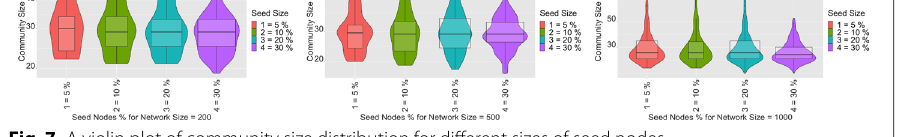
Fig. 7 A violin plot of community size distribution for different sizes of seed nodes on networks with sizes ranging from 200 to 1000. The value of parameters for deltaset = 0.3,0.55,0.60,0.65,0.70,0.75,0.80,0.85,0.90,0.95 , α = 1 and ν = 0.6 are the same in all cases. The green color corresponds to the tests with seed size = 10% of the network size, the pink color corresponds to tests with seed size = 5% of the network size, the blue color corresponds to tests with seed size = 20% of the network size, the purple color corresponds to tests with a seed size = 10% of the network the size in all